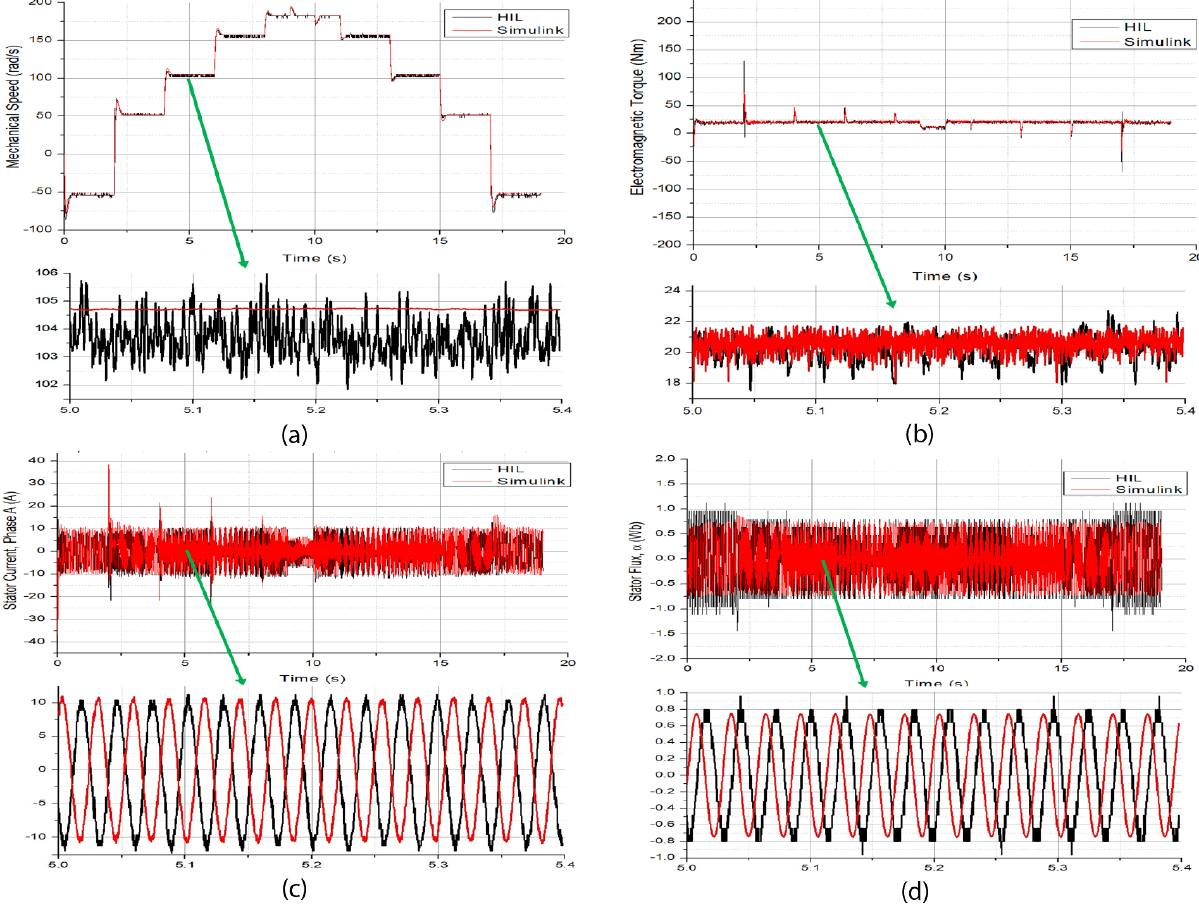
Figure 11. Numerical and practical results of the DTC variable speed controller: ( a ) speed; ( b ) torque; ( c ) stator current; and ( d ) stator